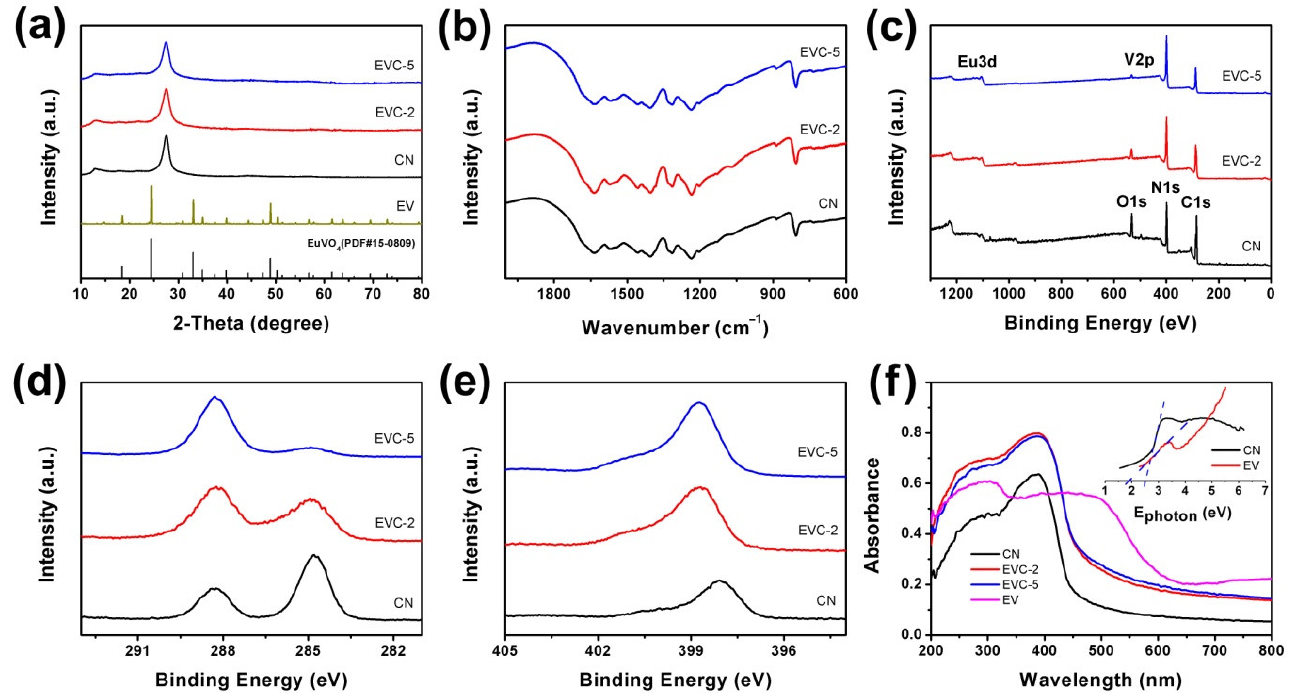
Figure 3. ( a ) XRD patterns, ( b ) FTIR spectra, ( c ) XPS survey spectra, high-resolution XPS spectra of ( d ) C1s, ( e ) N1s, and ( f ) UV-vis diffuse reflectance spectrum (Inset: band gap energy of CN and EV) of CN, EVC-2, and EVC-5.